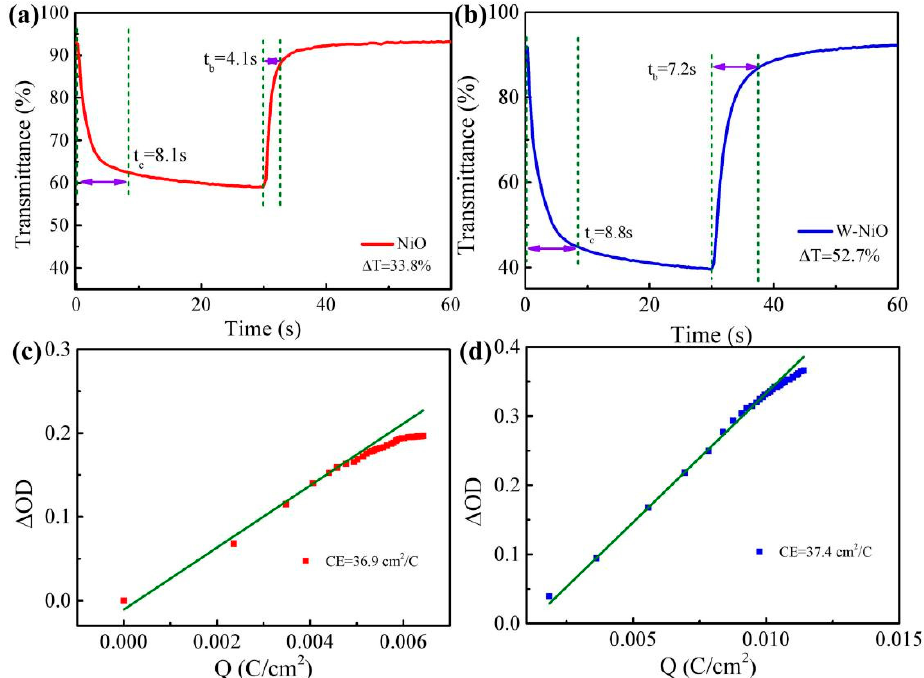
Figure 4. Time-dependent transmittance spectra ( a ) and CE ( c ) of the NiO film at 550 nm. Time- dependent transmittance spectra ( b ) and CE ( d ) of the W-NiO film at 550 nm.